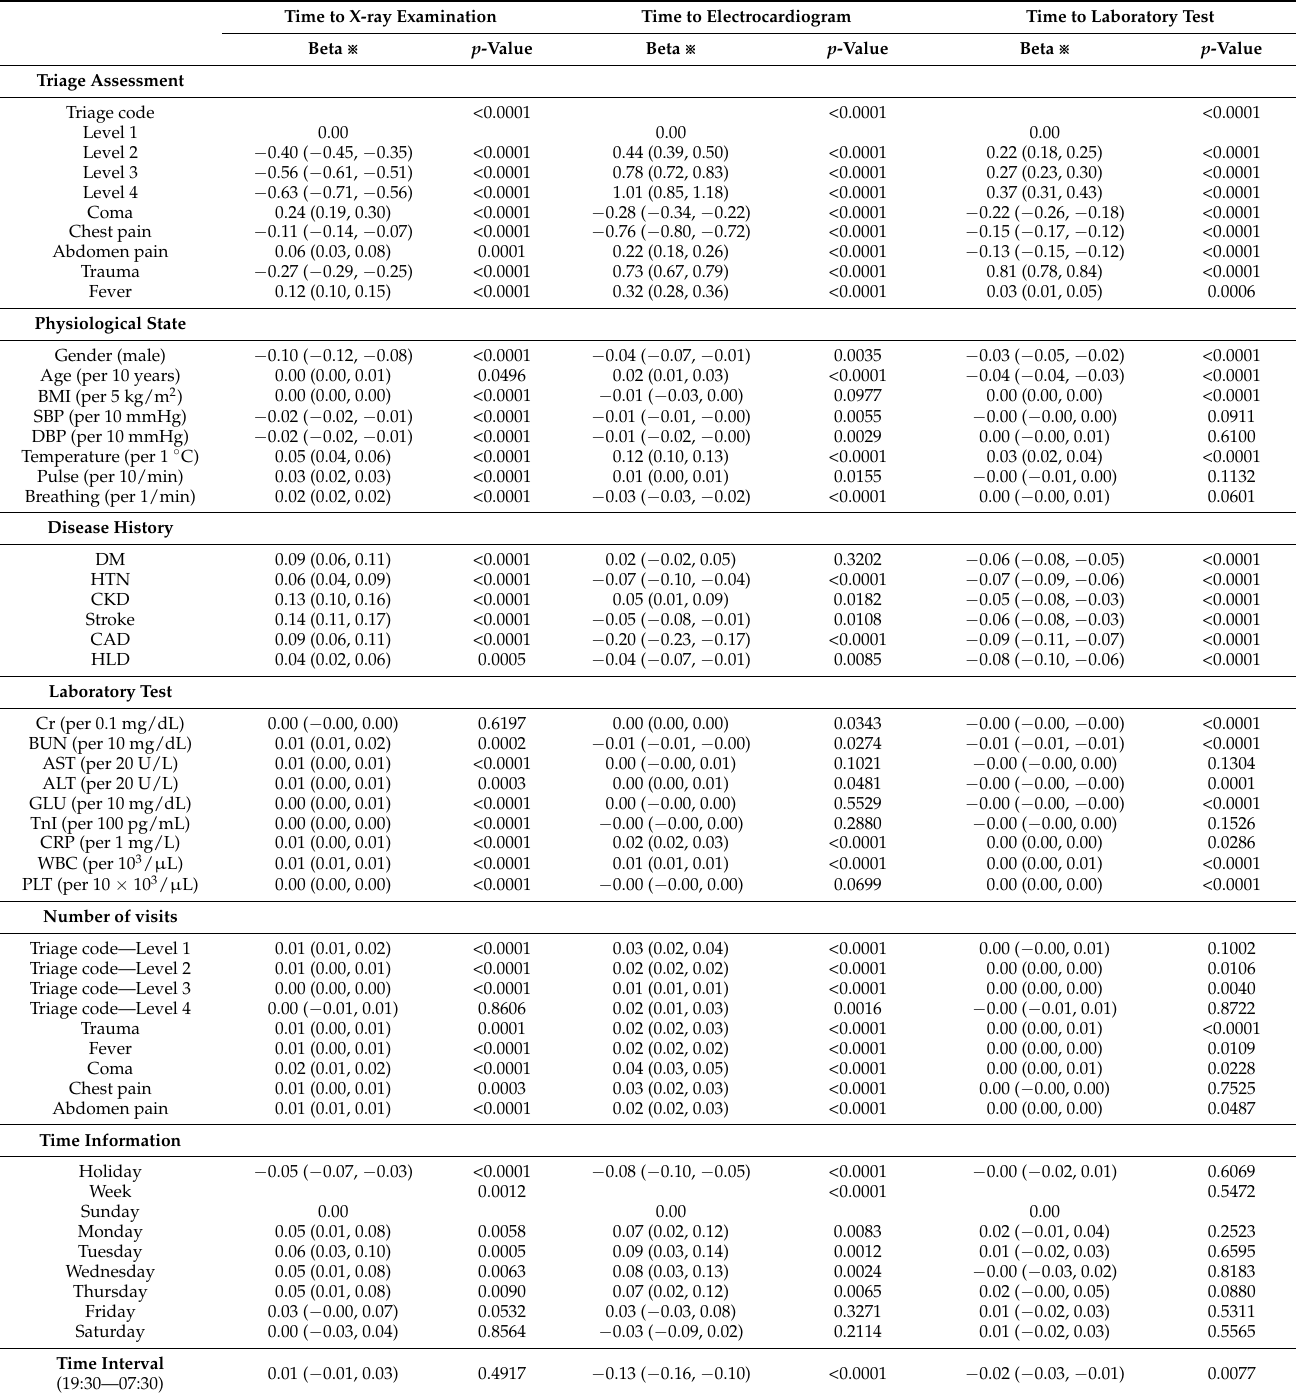
Table 4. Impact factors on time to examination